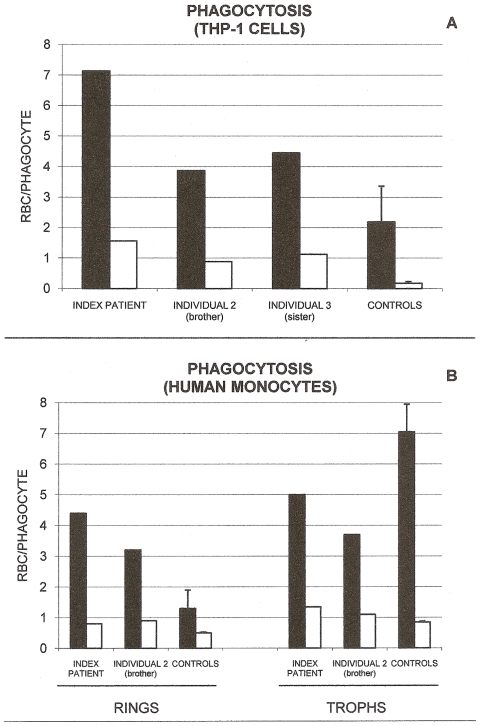
Phagocytosis of GR-deficient and GR-sufficient RBCs.Shown is the phagocytosis by THP-1 cells (panel A) of ring-infected and non-infected GR-deficient RBCs from the index patient, brother (individual 2) and sister (individual 3) of the index patient, and from normal GR-sufficient controls. Phagocytosis by human monocytes (panel B) of ring- and trophozoite-infected and non-infected GR-deficient RBCs from the index patient, brother (individual 2) of the index patient, and from normal GR-sufficient controls. Black bars indicate ring-/trophozoite-infected RBCs; open bars, non-infected RBCs. Phagocytosis is expressed as the number of ingested RBCs per phagocyte. Representative data of index patient, individuals 2 and 3, and mean values of normal controls (mean±SD, n = 3) are shown. For experimental details see Materials and Methods.